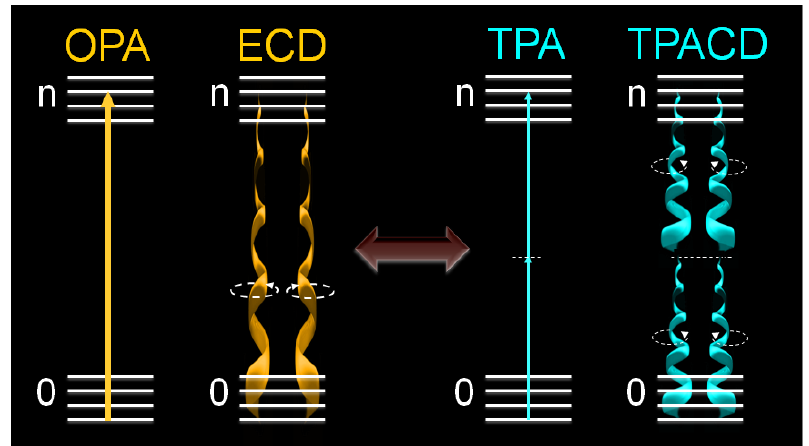
Figure 1. Comparative schematic between OPA and TPA processes as well as ECD and degenerate